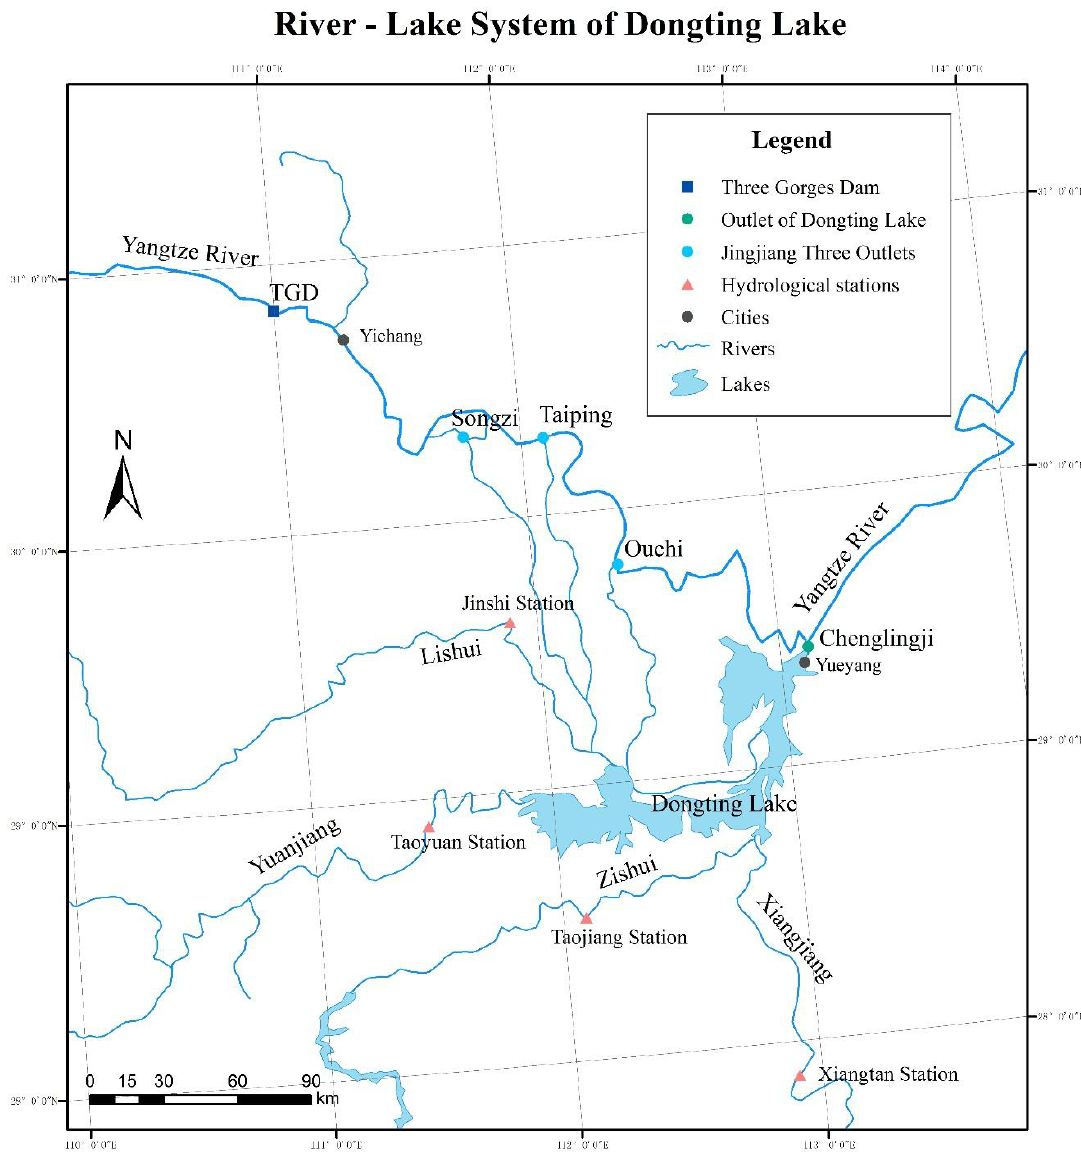
Figure 1. River–lake system of Dongting Lake.